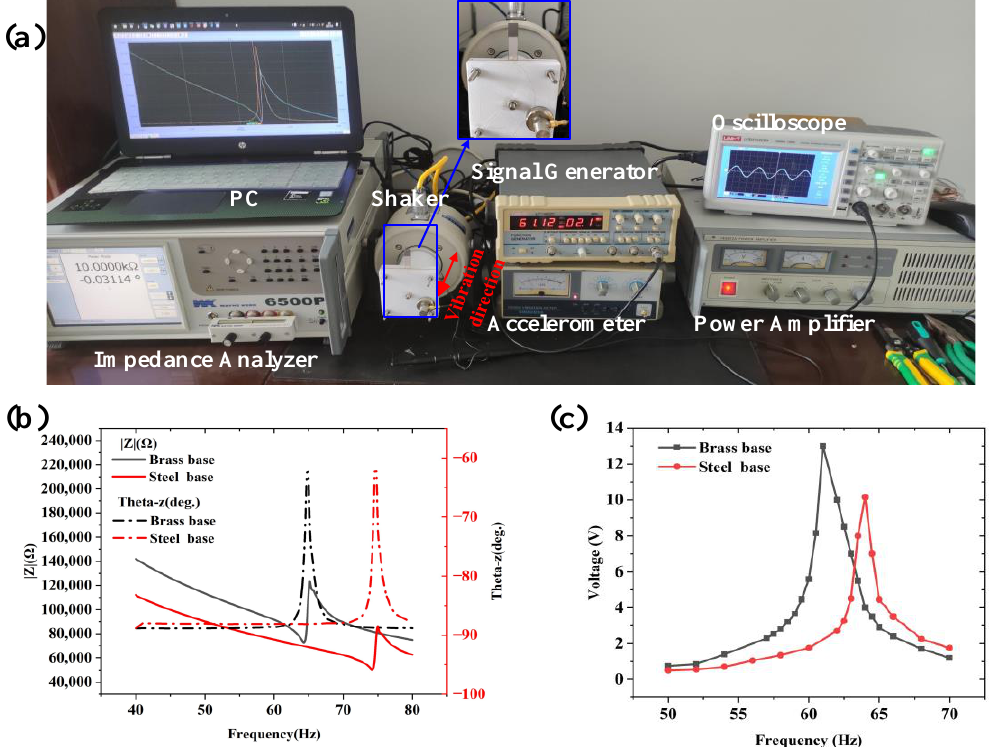
Figure 5. ( a ) Experiment and test platform of PEHs. ( b ) The impedance test results of the prepared S-PEH and B-PEH. ( c ) Voltage output of S-PEH and B-PEH at different frequencies.